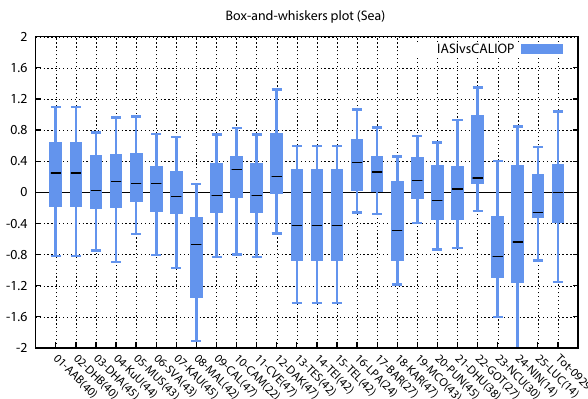
Figure 7. Box-and-whiskers plot (ends of the whiskers exclude the outliers) for the difference between IASI and CALIOP altitude over oceanic regions. y axis is in kilometres. Sites are identified by their number and code as defined in Table 4, followed by the number of items. Last box: overall result. NB: a systematic bias of − 0.4km (IASI–CALIOP) has been removed from the mean (all sites and